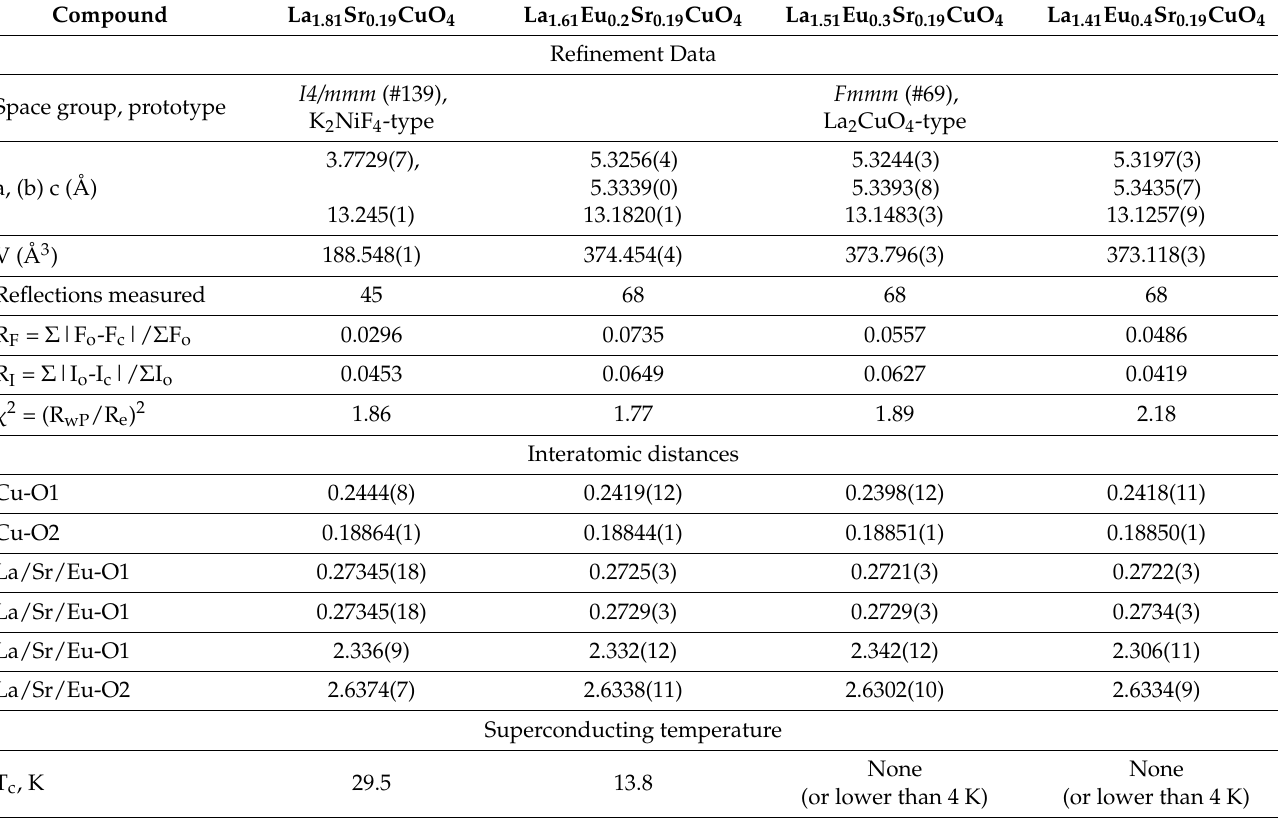
Table 1. Summary of structural and superconducting information for